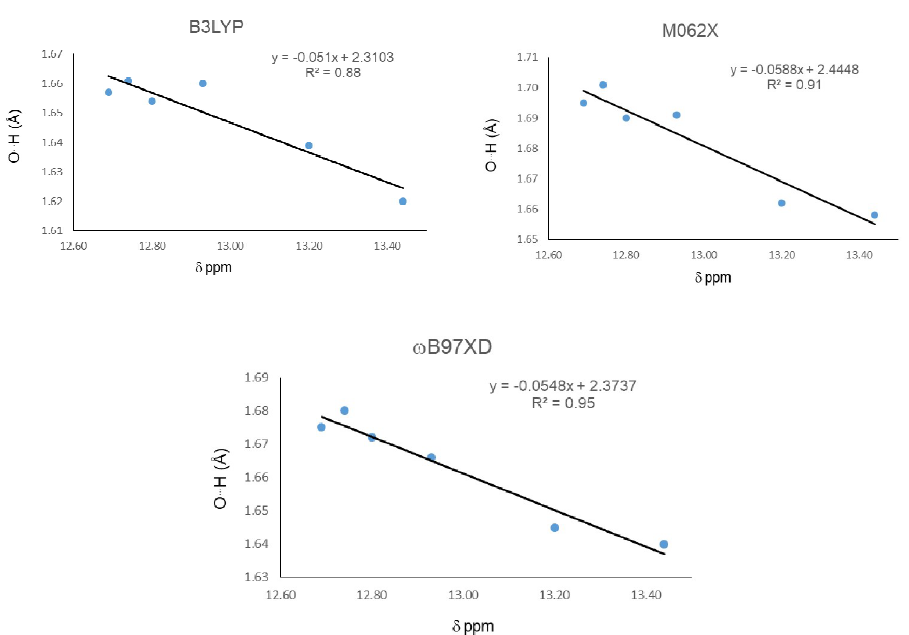
Figure 5. Correlations between O-H ... O distance and 1 H-NMR chemical shifts ( δ ) for the IMHB, excluding the weakest value.